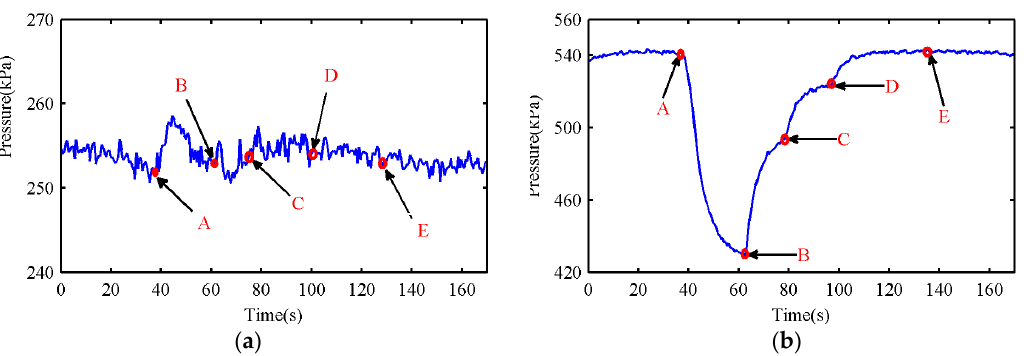
Figure 24. ( a ) First-stage exhaust buffer tank pressure of Experiment 1; ( b ) second-stage exhaust buffer tank pressure of Experiment 1. Table 6. Implementation optimization results of Experiment 1.